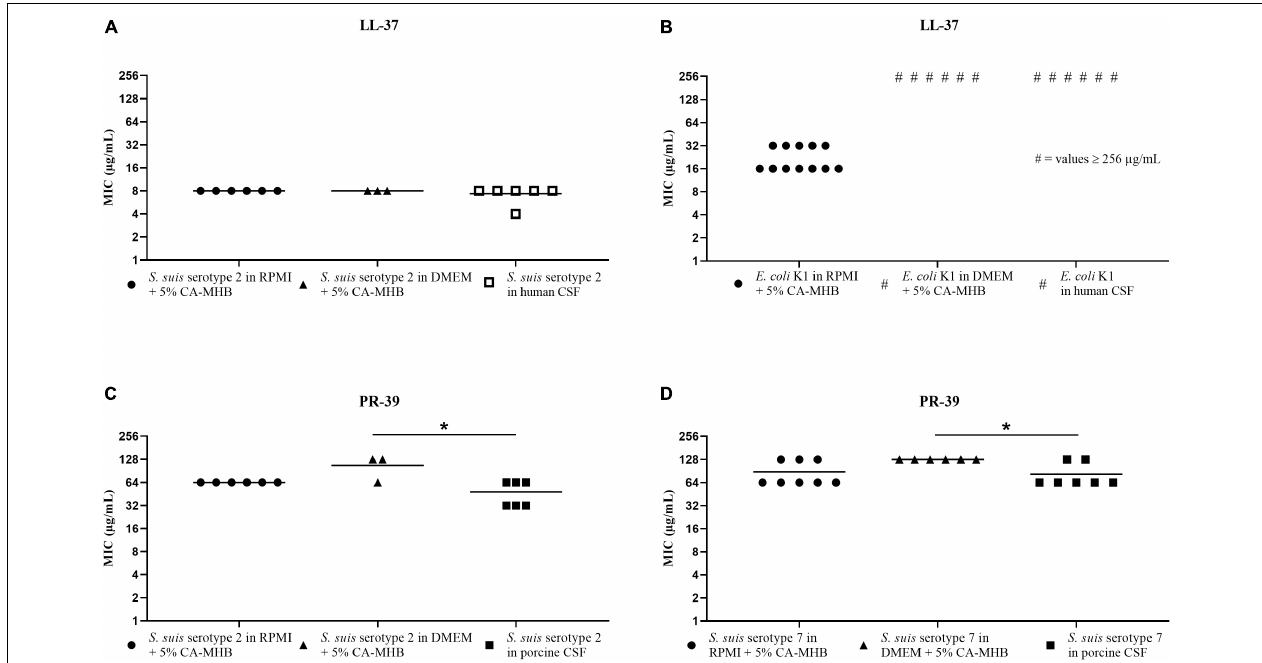
FIGURE 3 | MIC testing in human and porcine CSF, RPMI + CA-MHB and DMEM + CA-MHB (data shown are values from three independent experiments). Test of S. suis serotype 2 against LL-37 (A) and PR-39 (C) , E. coli K1 against LL-37 (B) and S. suis serotype 7 against PR-39 (D) . Statistics: Kruskal–Wallis test with subsequent Dunn’s comparisons test ∗ p <